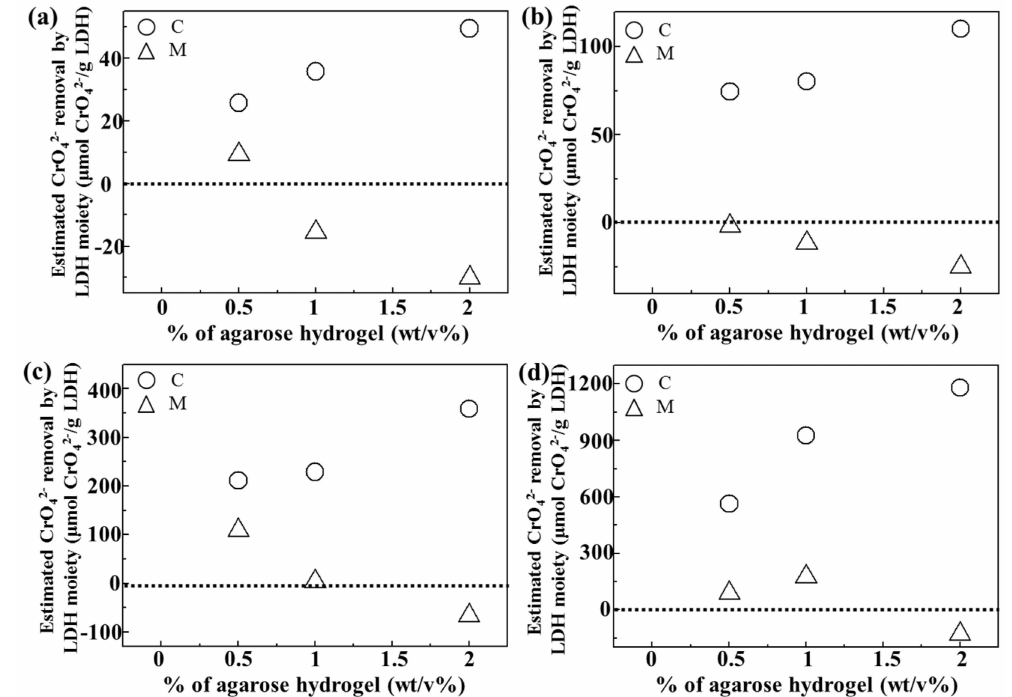
Figure 6. Estimated chromate removal efficacy ( µ mol/g) by LDH moiety in LDH-agarose composite (C) and LDH-agarose mixture (M) samples at initial chromate concentration of ( a ) 50 ppm, ( b ) 100 ppm, ( c ) 200 ppm, and ( d ) 400 ppm, respectively. For calculation, chromate removal by C or M sample was subtracted by the chromate removal by agarose only at the same chromate